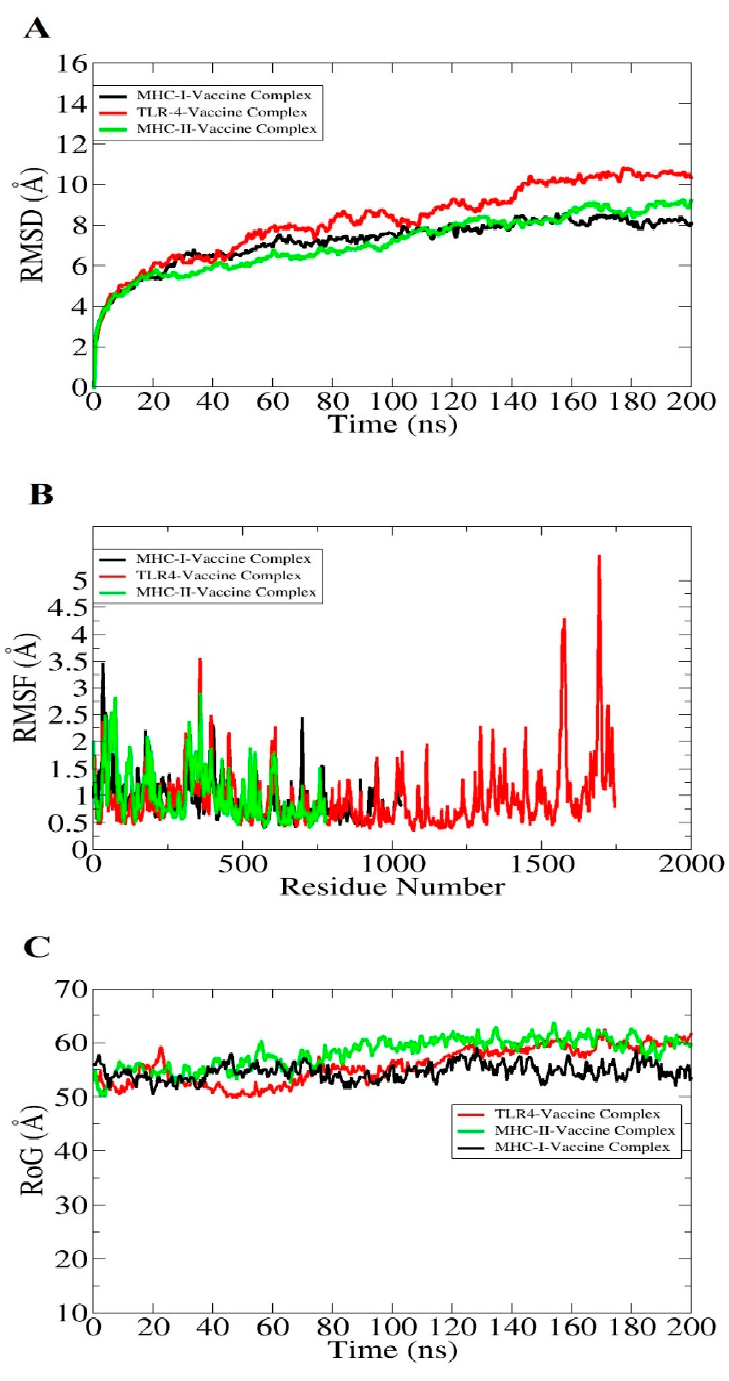
Figure 9. Statistical analysis of simulation trajectories; three output values are depicted here: RMSD ( A ), RMSF ( B ), and RoG ( C ). RMSD ( A ), RMSF ( B ), and RoG ( C